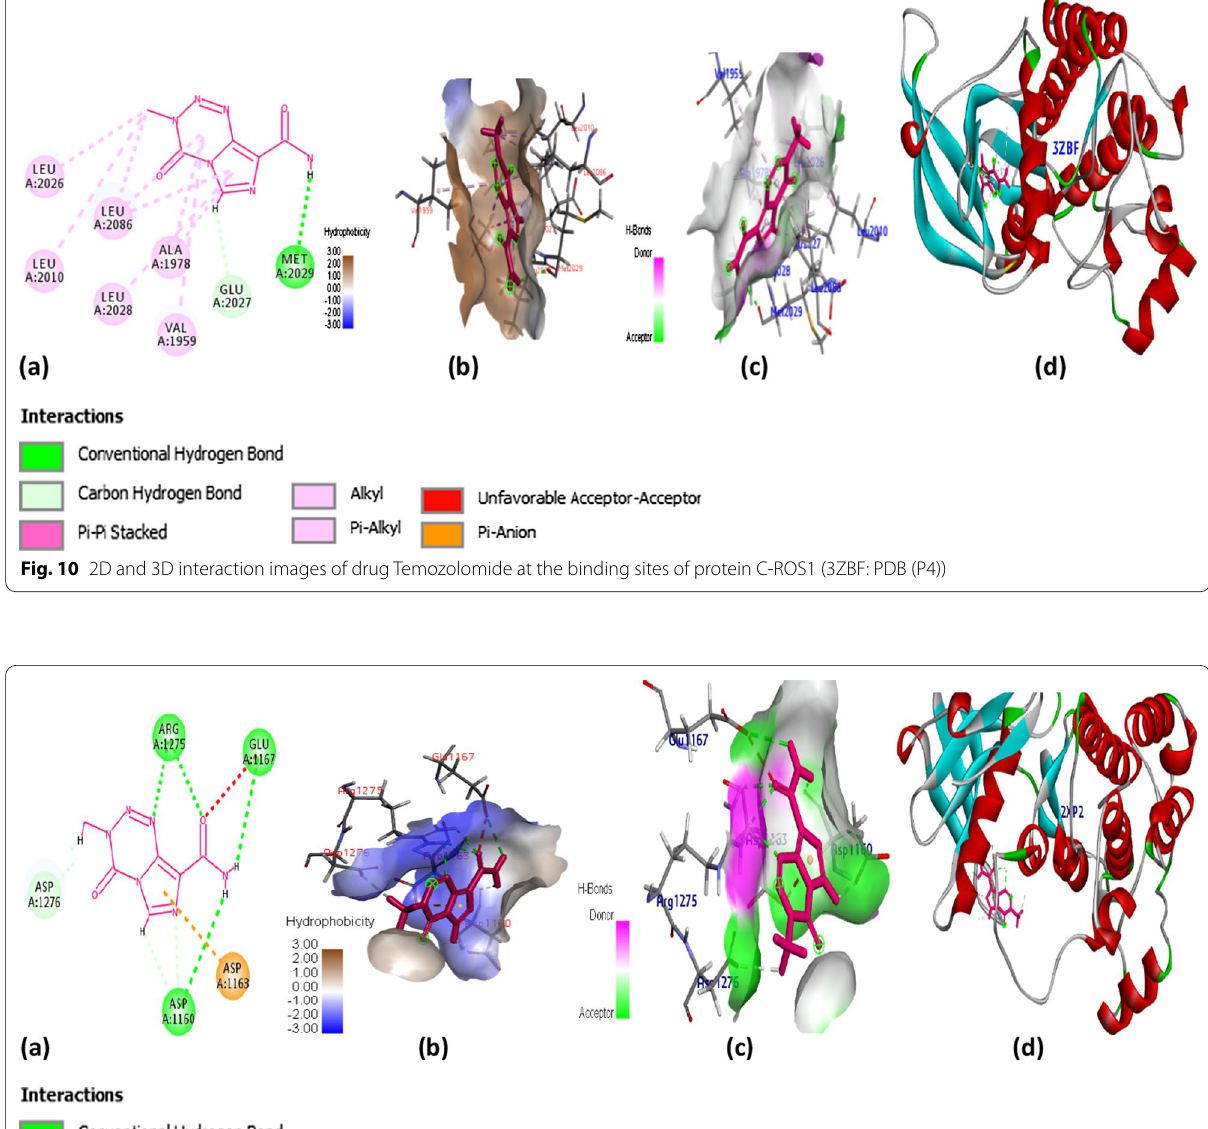
mide complex: 2WGJ (Direct (P4))) and